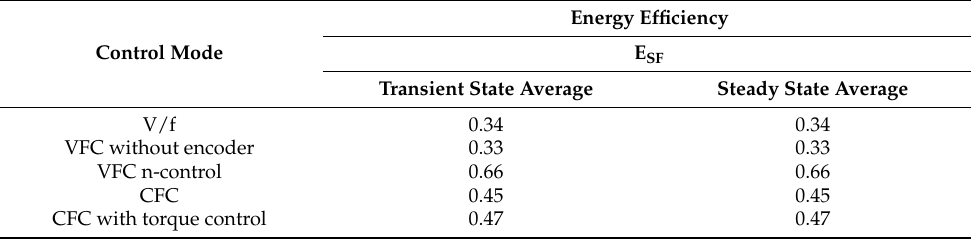
Figure 6. Comparison of the energy saving factor (E SF ) for various control modes (without an external load). Based on the calculated S C and E SF , the E F was determined and averaged over two drive states: the transient state and steady state in the unloaded condition. The results are presented in Table 10. Table 10. Characteristics of the energy efficiency E SF in the steady state (without an external load).